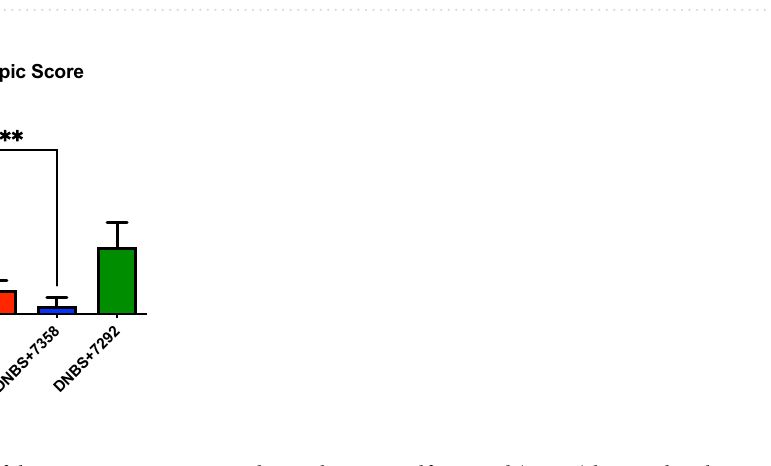
Figure 5. Evaluation of the macroscopic score in a dinitro-benzene sulfonic acid (DNBS) low grade colitis model after treatment with the EPS variants 7292 and 7358 in comparation with the wild-type L. rhamnosus CNCM I-3690. Significance: * p <